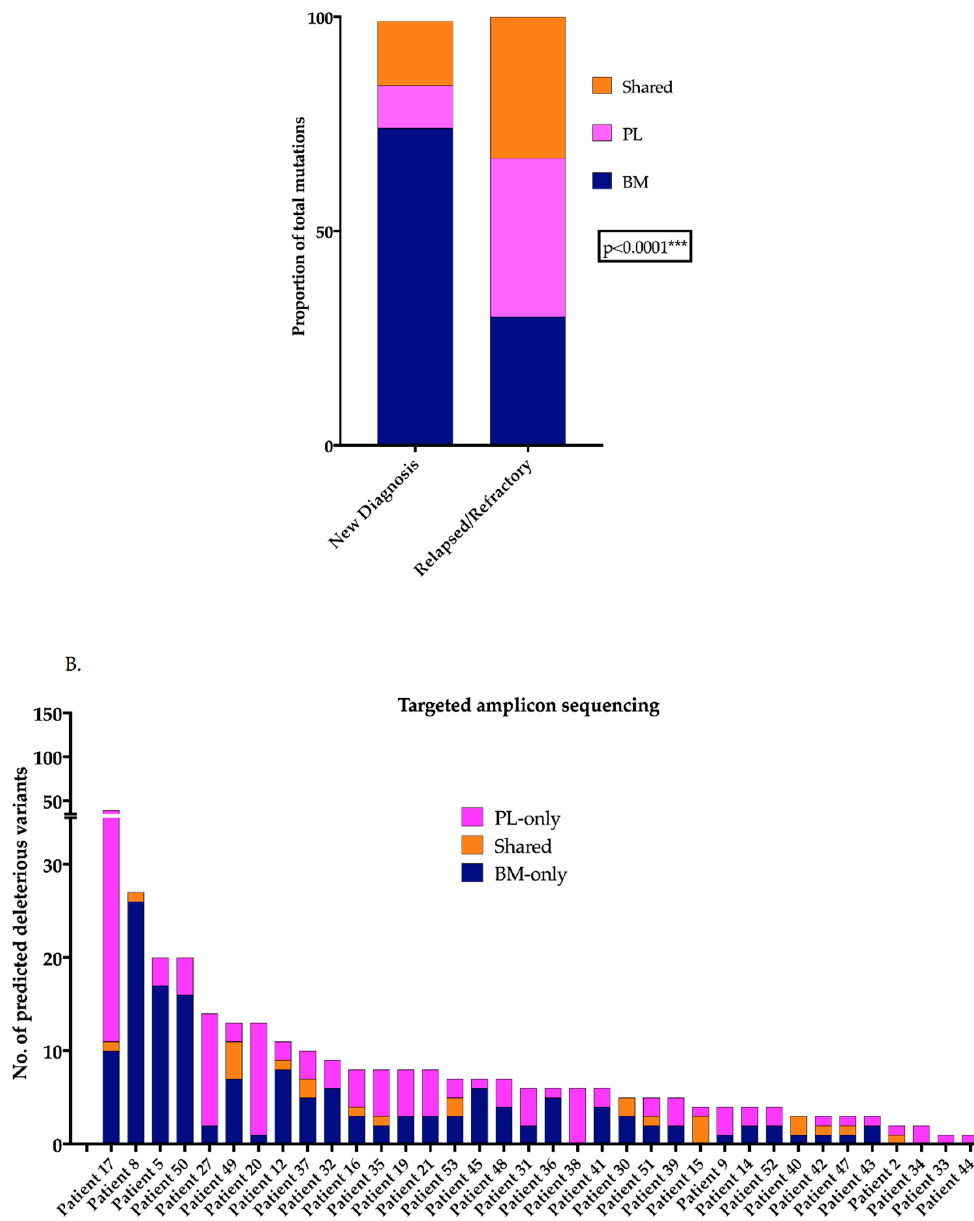
Figure 1. PL-exclusive mutations are present in MM patients ( A ) Column graph represents the proportion of mutations within the ND and RR patients (OMD) indicating the significant increase in the proportion of mutations detected in the PL-only in RR patients (Chi-square test, *** p < 0.0001) ( B ) Column graph represents the number of predicted deleterious and cancer driver variants in matched BM and PL samples obtained from 36 patients through TAS with 92% of patients harbouring variants present exclusively in the PL. PL: plasma, MM: multiple myeloma, ND: new diagnosis, RR: relapsed/refractory, OMD: OnTarget TM mutation detection, TAS: targeted amplicon sequencing. 2.2. Patients with Higher Number and Tumour Burden of PL Mutations Have Significantly Shorter Survival